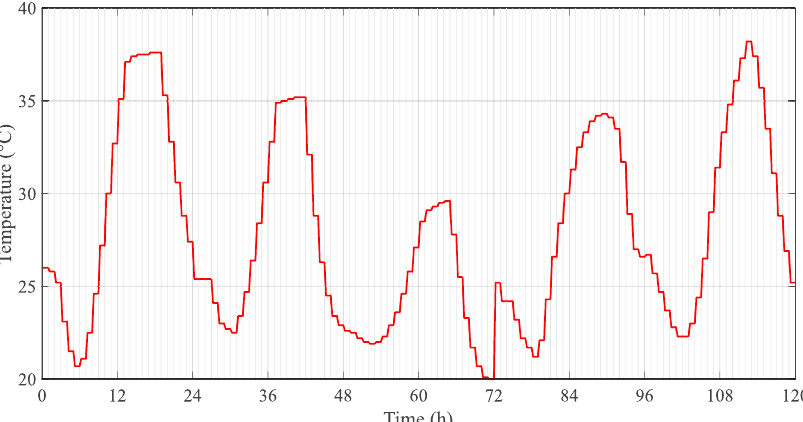
Figure 5. Forecast of the external temperature over the five days